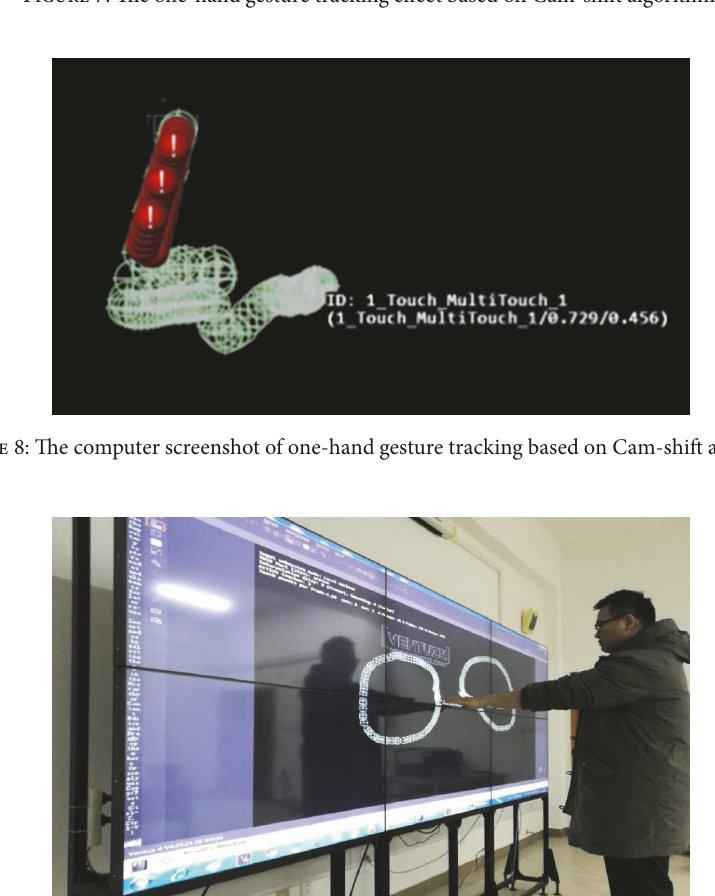
Figure 7: The one-hand gesture tracking effect based on Cam-shift algorithm.